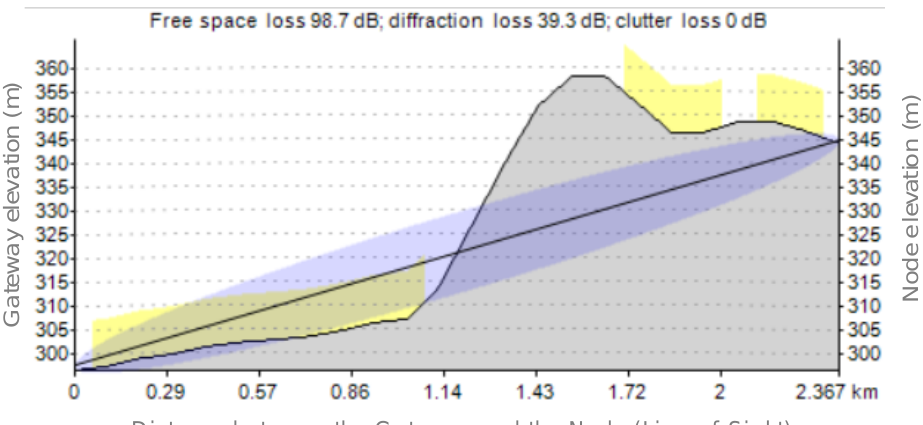
Figure 10. Losses due to the geographical terrain variation for Scenario 1.